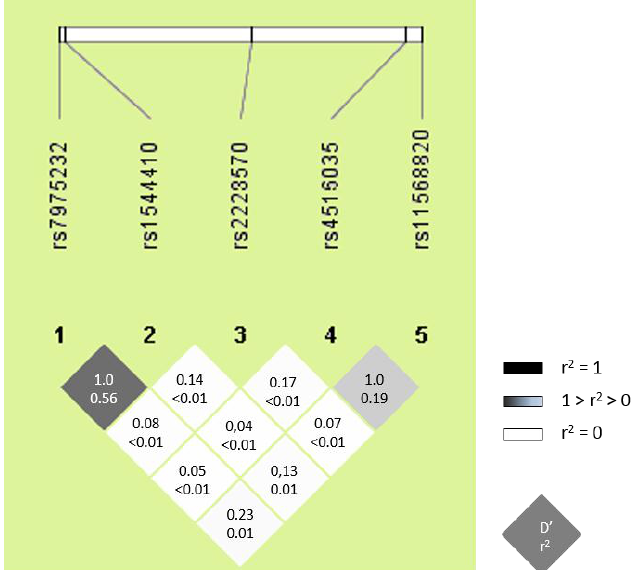
Figure 1. Pairwise linkage disequilibrium (LD) pattern for VDR polymorphisms. The locations of each tested SNP, along the genome region, is indicated on top. Each diagonal represents a different SNP, with each square representing a pairwise comparison between two SNPs. The number in each square indicates the magnitude of LD, expressed as D´ and r 2 . Color scheme: Grey color intensity decreases with decreasing R -squared value. Dark grey indicates strong LD; squares in light grey indicates weaker LD; white indicates very weak or no LD.